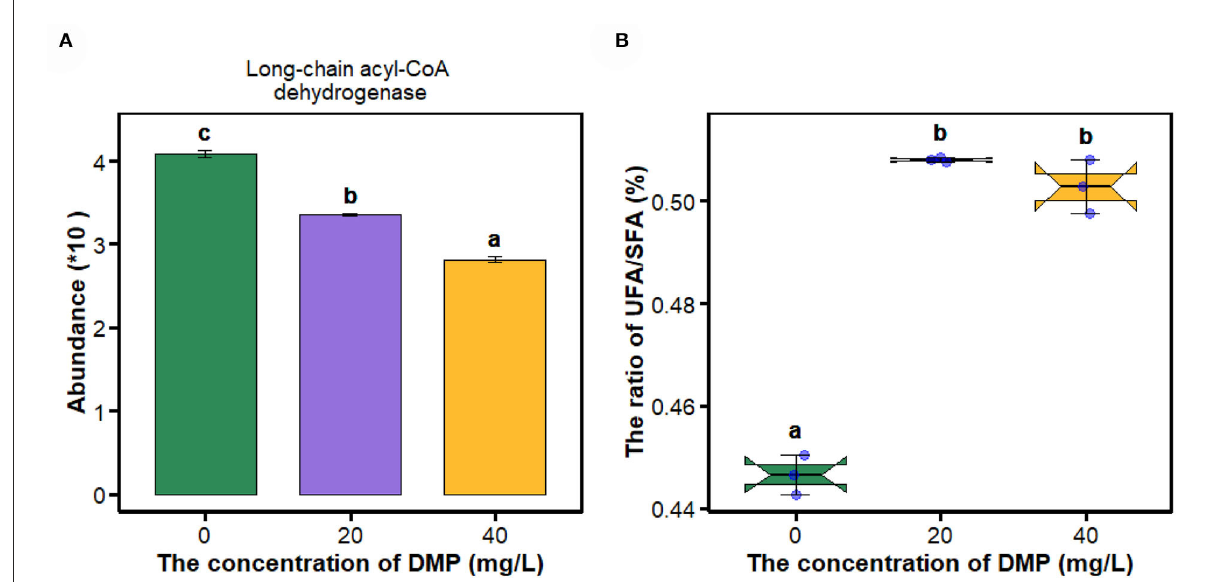
FIGURE2 The expression of proteins in the fatty acid metabolism pathway and the ratio of UFA/SFA of P. fluorescens were altered by DMP contamination. (A) shows that DMP inhibited the expression of long-chain acyl-CoA dehydrogenase abundance through proteomics, and (B) shows that the ratio of UFA/SFA of P. fluorescens was changed by DMP treatment. Different letters represent significant differences between